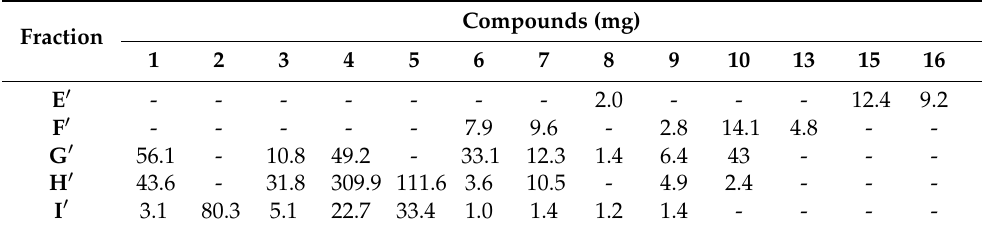
Figure 4. Bioactivities obtained in the etiolated wheat coleoptile bioassay for the dichloromethane extract and the fractions obtained by chromatography of the citrus waste from Citrus sinensis. Values are expressed as percentage difference from control. Table 1. Amounts of compounds isolated from the most active fractions of the dichloromethane extract.